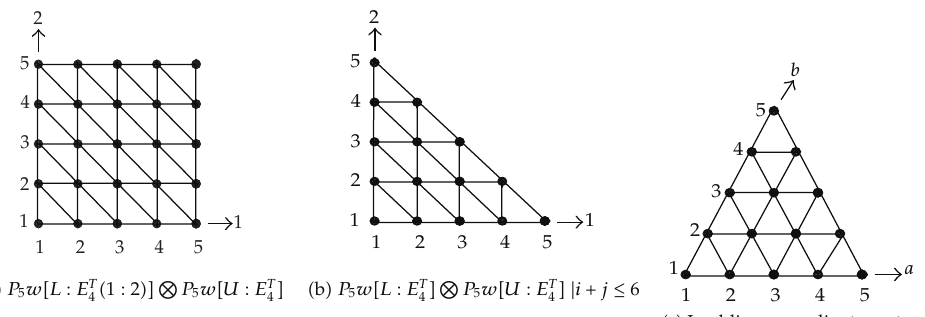
Figure 11: Geometrical conditions and transformation between Cartesian and oblique coordinate systems applied to a weighted graph